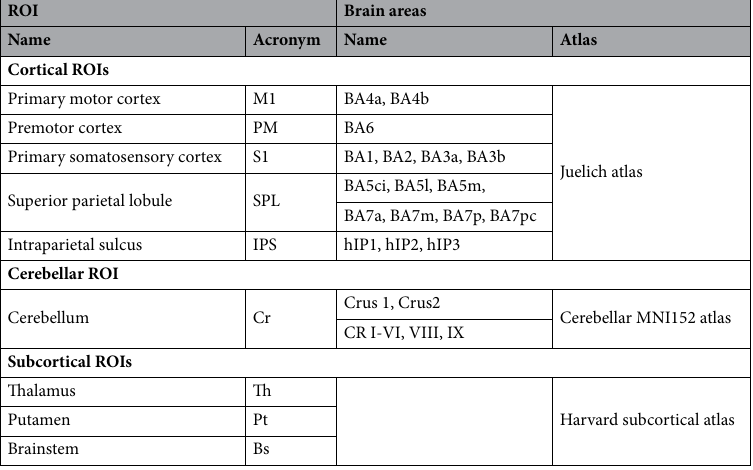
Table 1. Definition of ROIs for test-retest reliability analysis. For each region listed above, with the exception of the Brainstem, we created two ROIs for the left and right hemisphere. BA: Brodmann Area, CR: Cerebellar Region, hIP: human IntraParietal